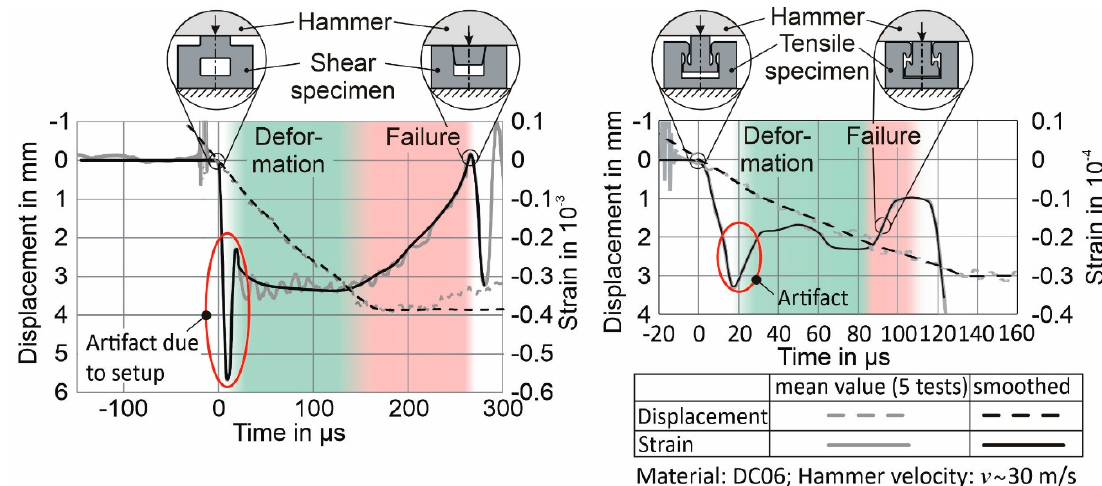
Figure 16. Hammer displacement and load course (elastic strain of the measurement body) measured on the electromagnetically driven setup for a hammer velocity of approximately 30 m / s. The curves shown here have been measured with a 6 mm thick measurement body.